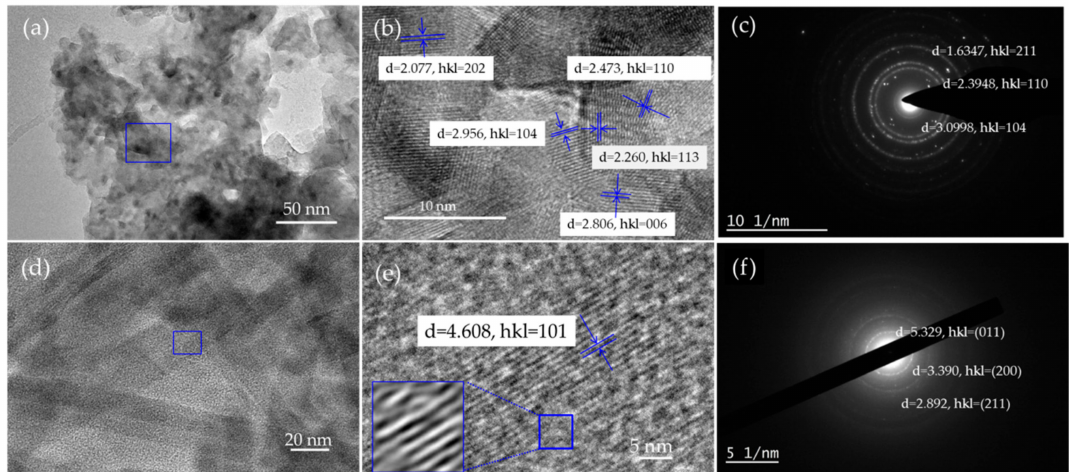
Figure 5. HRTEM and SAED results of the biotic Mg-rich calcite and struvite nanoparticles: ( a ) HRTEM image of Mg-rich calcite nanoparticles; ( b ), enlarged image of the area marked by a blue square in a; ( c ) SAED results corresponding to the area marked by the blue square in a; ( d ), HRTEM image of a struvite nanoparticle; ( e ), enlarged image of the area marked by a blue square in d; ( f ) SAED results corresponding to the area marked by a blue square in d.